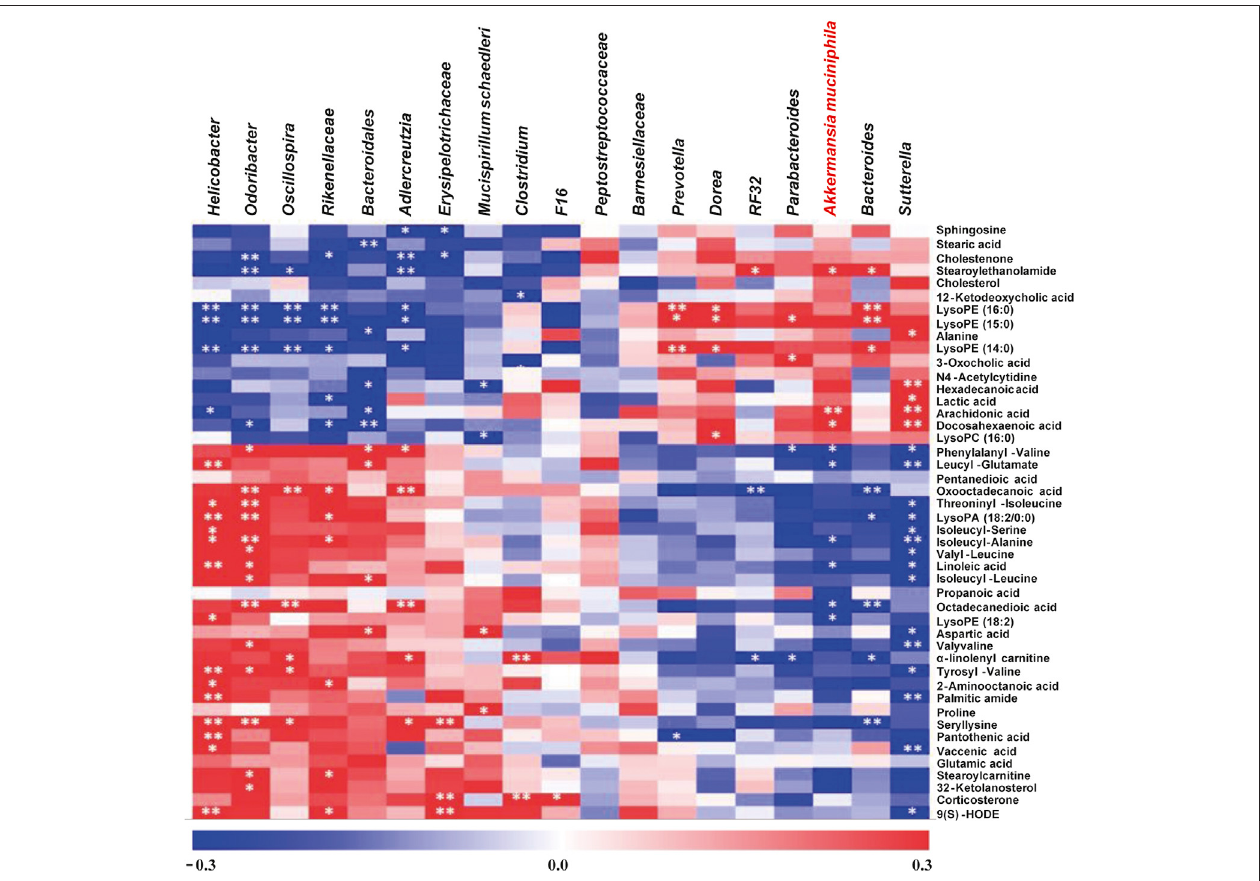
FIGURE 6 | Non-target metabolomics analysis to explore the potential gut microbiota-metabolite axis for FOLFOX ef fi cacy. The intensity of the colors represents thedegreeofassociationbetweentherelativelevelofmetabolitesandtheabundanceofchangedbacterialgenerabySpearman ’ scorrelations.The p -values < 0.05were considered statistically signi fi cant, * p < 0.05, ** p <